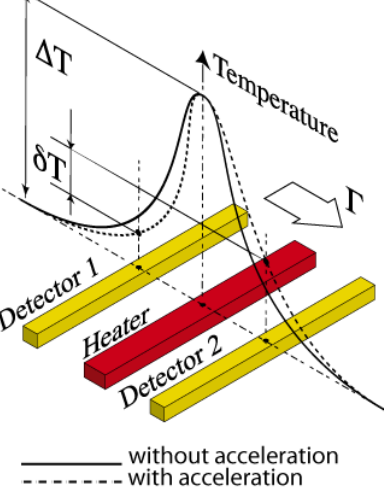
Figure 1. Temperature profile with and without